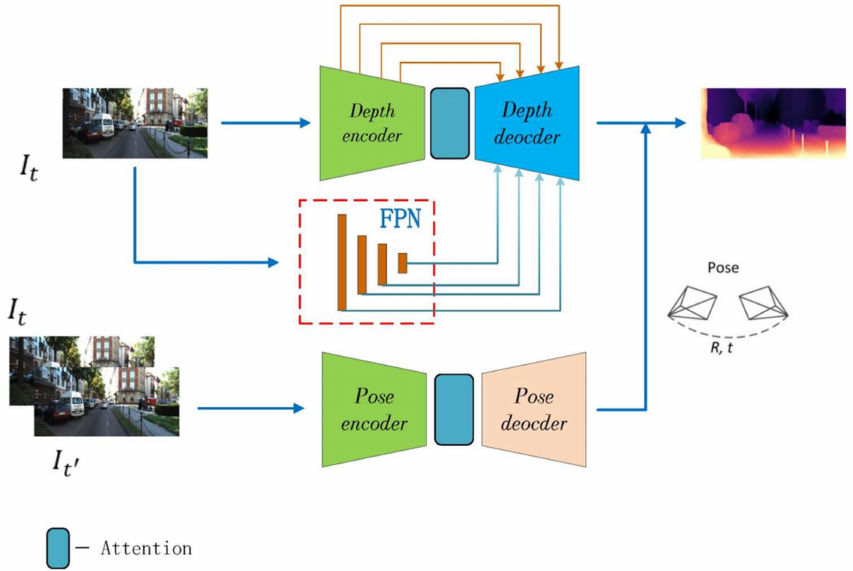
Figure 1. Self-supervised monocular depth estimation U-net model with the FPN and the attention mechanism